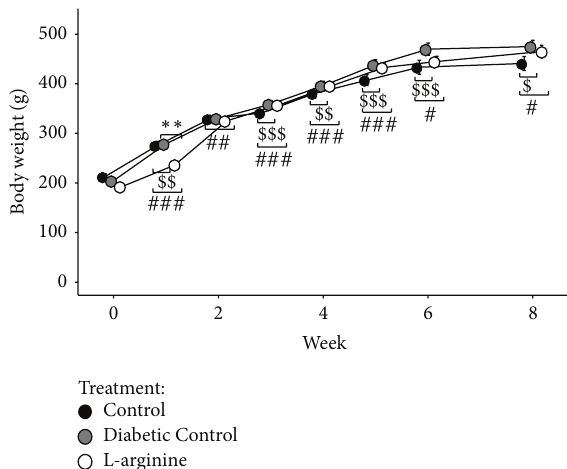
Figure 2: Effect of the high fructose diet alone (Diabetic Control) and high fructose plus L-arginine diet (L-Arginine) on weight again over 8 weeks. Data are represented as means ± standard